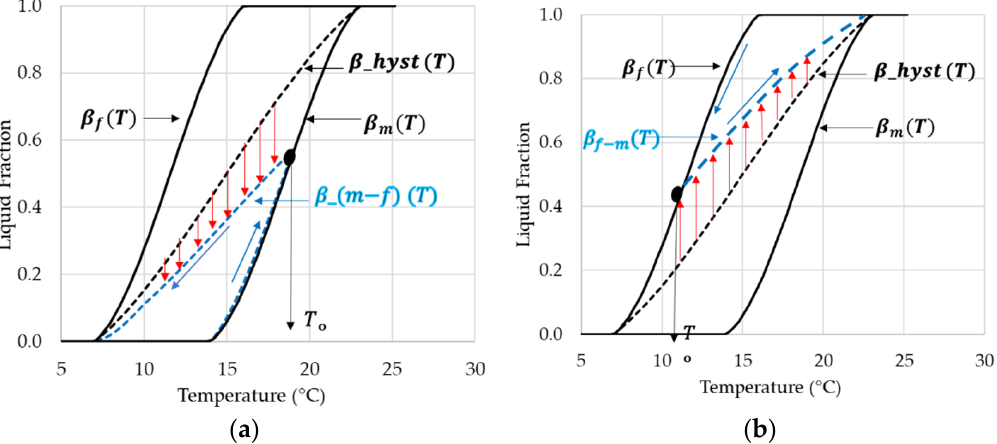
Figure 4. Illustration for hysteresis model in incomplete phase change process: ( a ) transition from melting to freezing, ( b ) transition from freezing to melting.